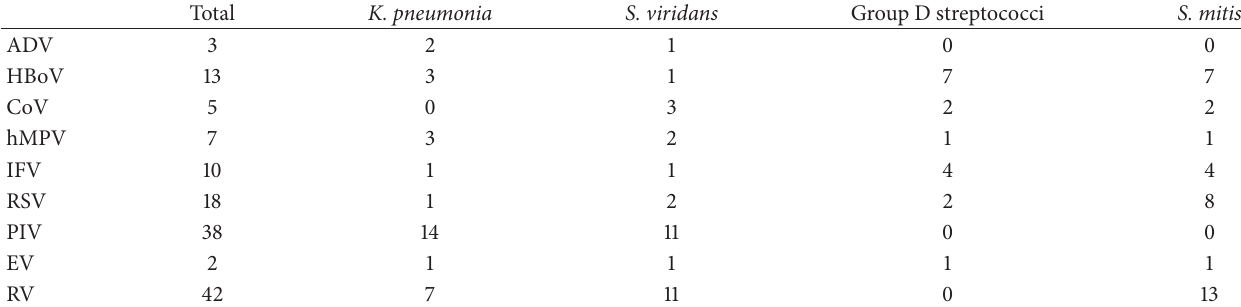
Table 5: The number of patients with a combination of viral and bacterial pathogens in patients with LRTIs.